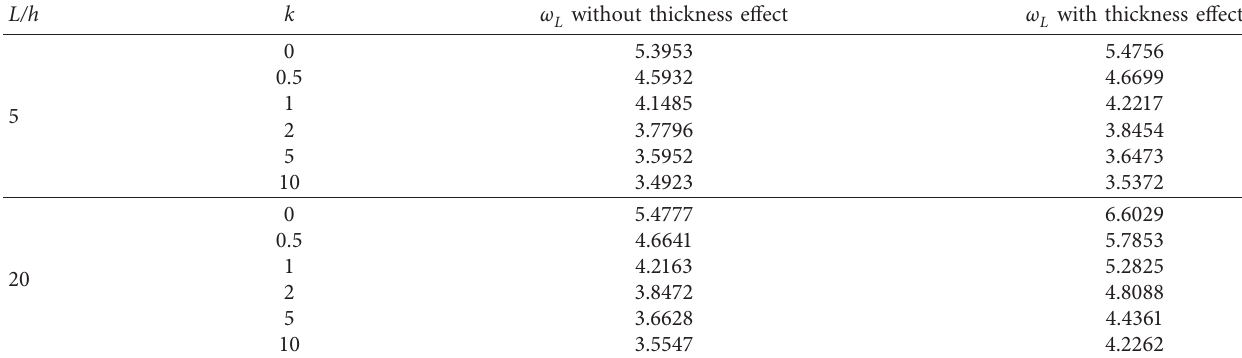
Table 4: The first nondimensional natural frequencies of FG nanobeams for α � 0 . 01 and β � 0 . 01.